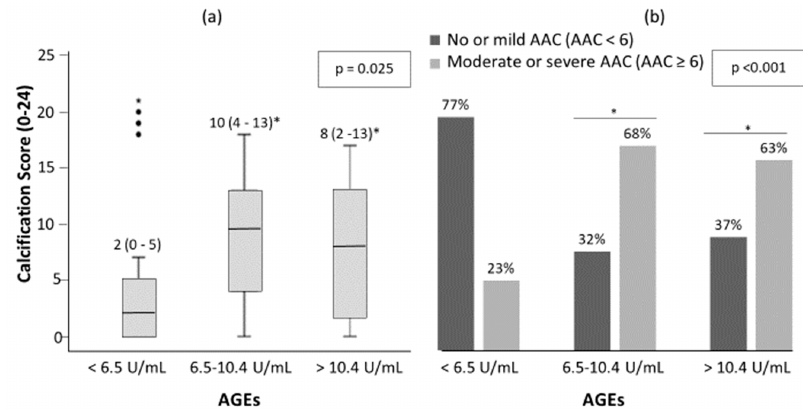
Figure 2. Abdominal aortic calcification (AAC) score ( a ) and percentage of patient with no-mild AAC and moderate-severe AAC ( b ) among AGEs levels in patients with DM2. The significance of di ff erences between groups were determined using Kruskal–Wallis and Mann–Whitney U test for ( a ); and chi-square test for ( b ). * p < 0.05 vs. low serum levels of AGEs ( < 6.5 U / mL). J. Clin. Med. 2020 , 9 , x FOR PEER REVIEW